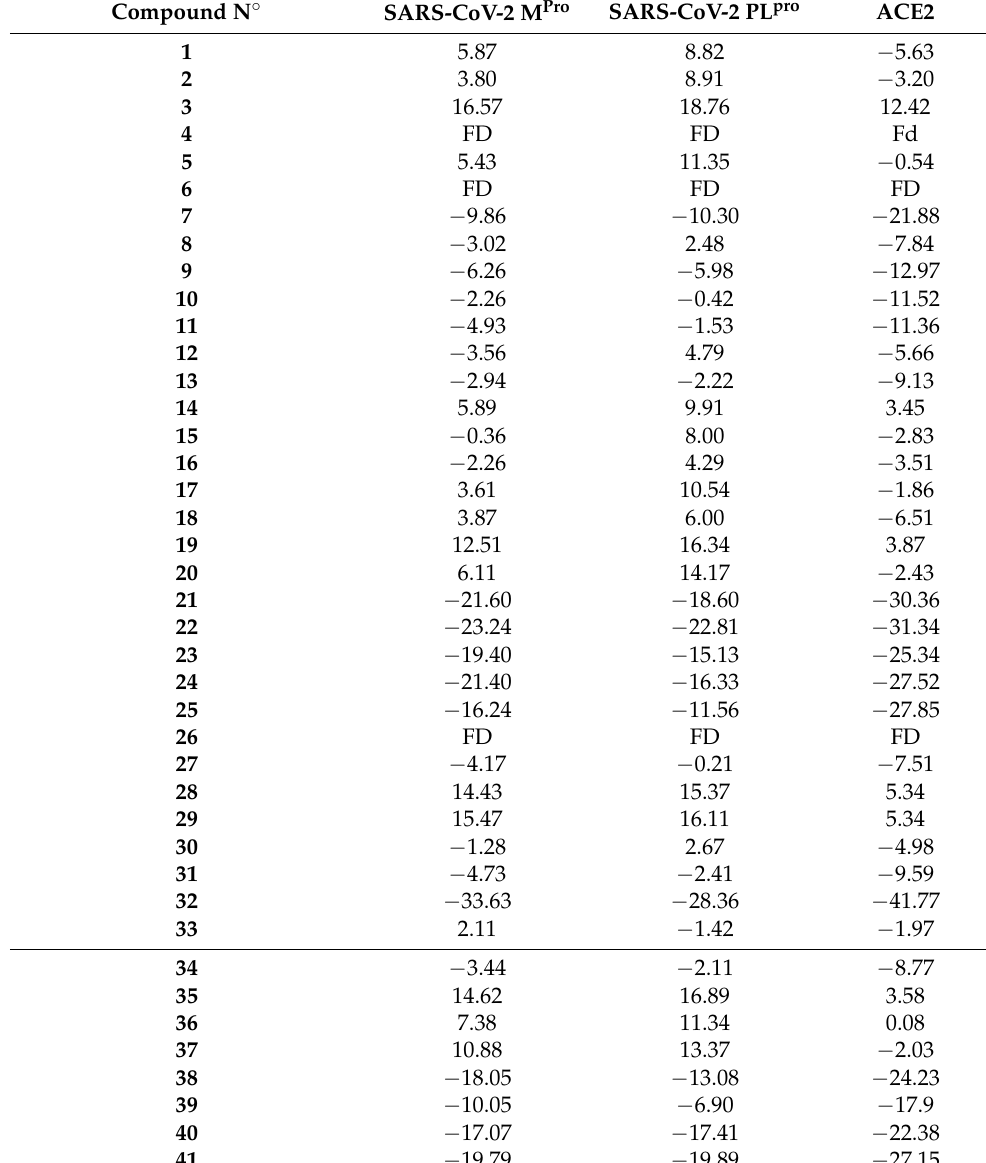
Table 1. Binding energies ( ∆ G) (kcal/mol) of the tested cannabinoids using in silico studies within the active centers of SARS-CoV-2 M Pro , SARS-CoV-2 PL pro and angiotensin-converting enzyme 2 (ACE2) using pH-ionization